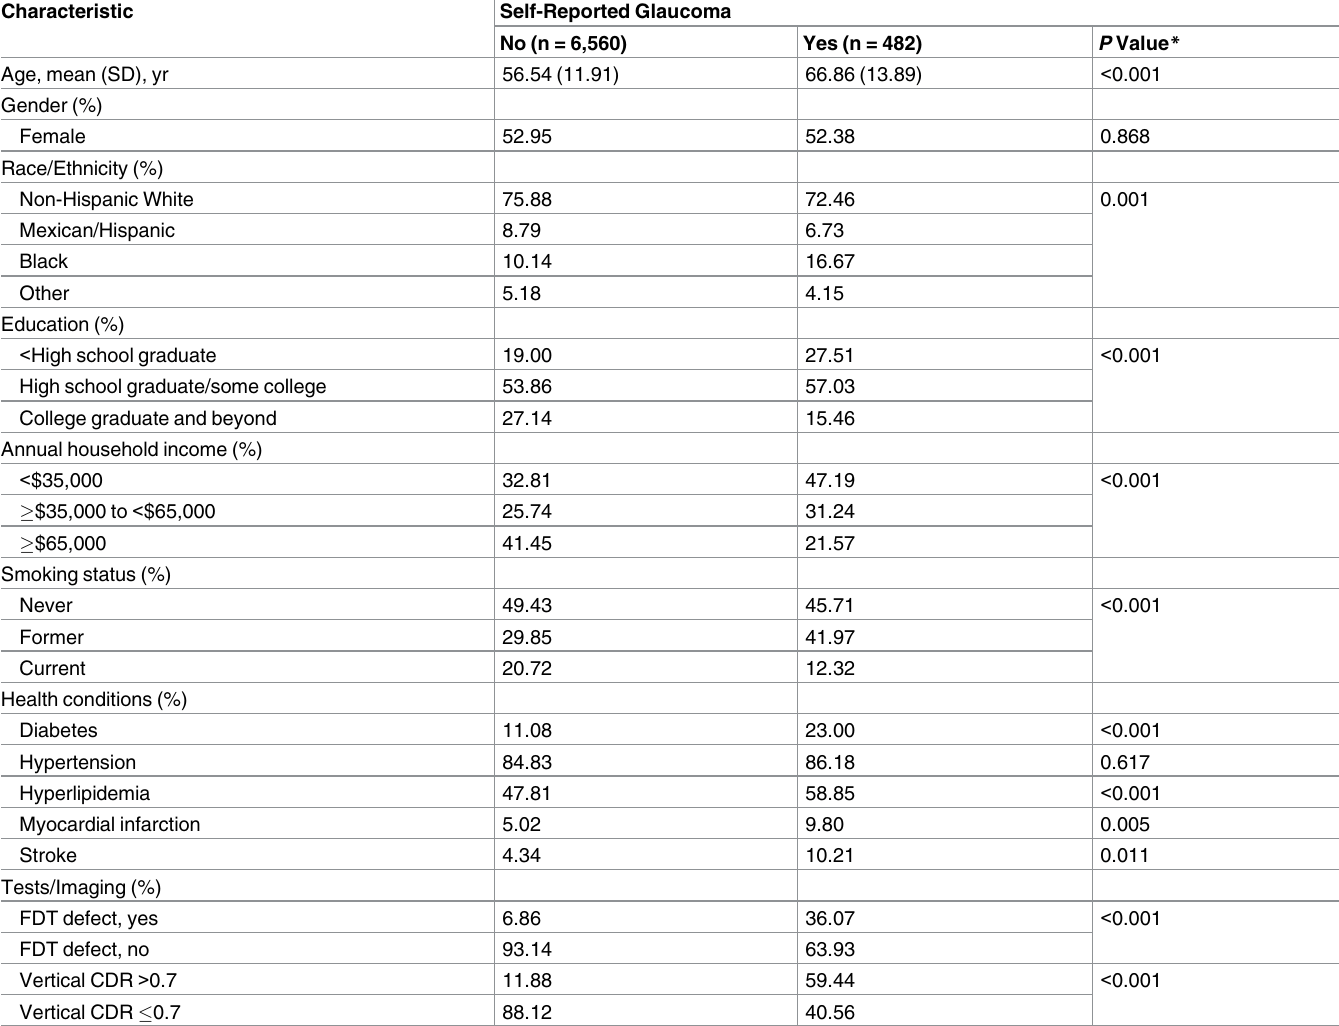
Table 1. Demographic and general health characteristics of participants age (cid:21) 40 yearsbased on self-reported glaucoma status, in the National Health and Nutrition Examination Survey (NHANES)2005–2008(n = 7042).